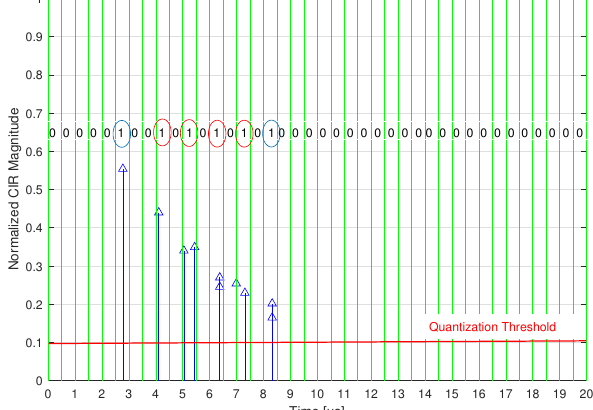
Figure 9. CIR of Scenario